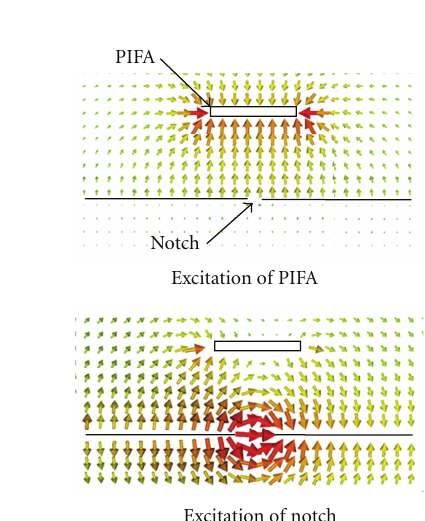
Figure 3: Investigation of misplacement or rotation of PIFA.